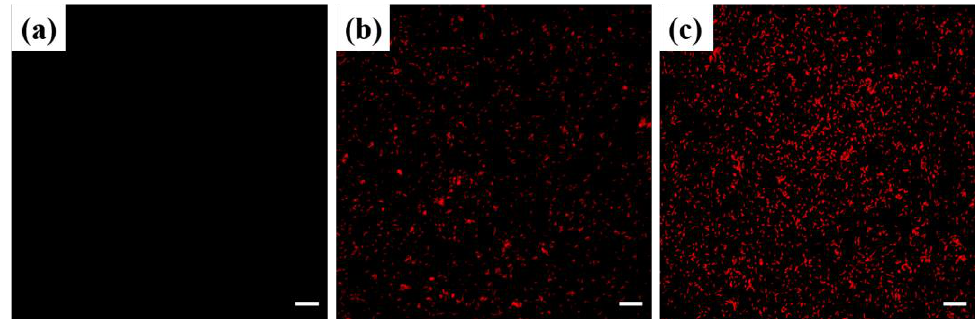
Figure 7. Fluorescence images of C 4 -treated Xoo cells stained with PI: ( a ) Control, ( b ) 4.04 µg mL − 1 , and ( c ) 16.16 µg mL − 1 . Scale bars: 10 µm.